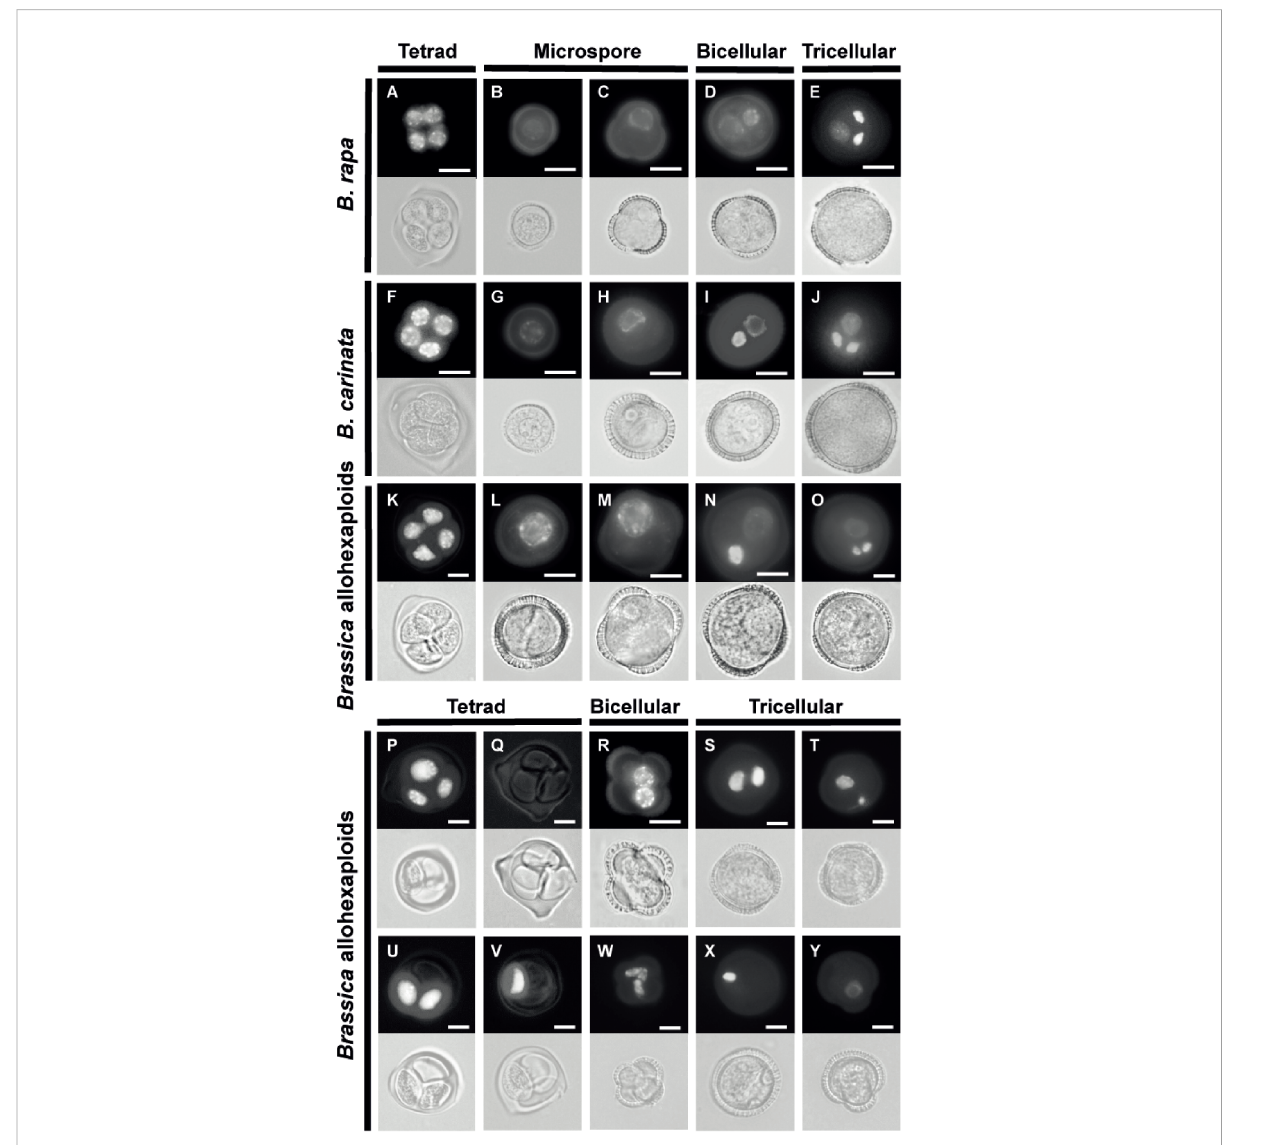
FIGURE 2 Abnormal pollen development in the synthetic Brassica allohexaploids. Normal pollen development in B. rapa (A – E) , B. carinata (F – J) and Brassica allohexaploids (K – O) at different stages. Abnormal pollen development in the Brassica allohexaploids at the tetrad stage (P , Q , U , V) , the bicellular stage (R , W) and the tricellular stage (S , T , X , Y) . Fluorescent (up) and bright- fi eld images (down) are shown. Bars = 10 m